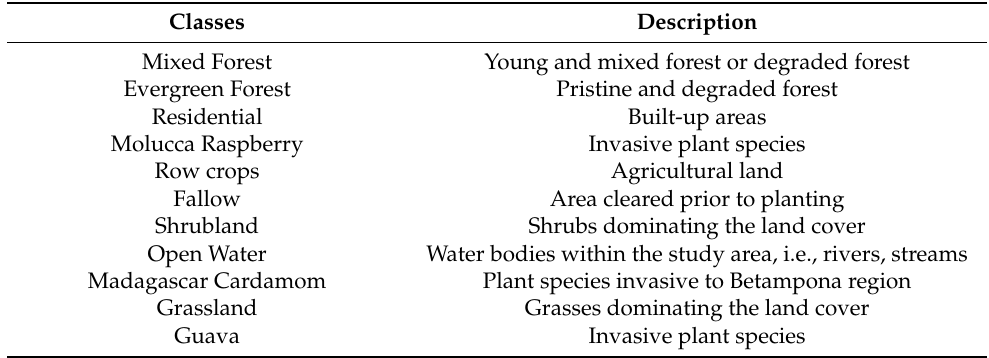
Figure 2. In situ images of a few classes being mapped, collected during the ground reference data collection in 2018. Additional classes include invasive guava, residential, and open water. Table 1. This table lists the classes and descriptions used in order to create the classification map. Eleven classes were defined that relate to land cover (Open Water, Row Crops), land use (Residen- tial, Fallow), and forest cover (Mixed Forest, Evergreen Forest, Molucca Raspberry, Shrubland, Madagascar Cardamom, Grassland and Guava).